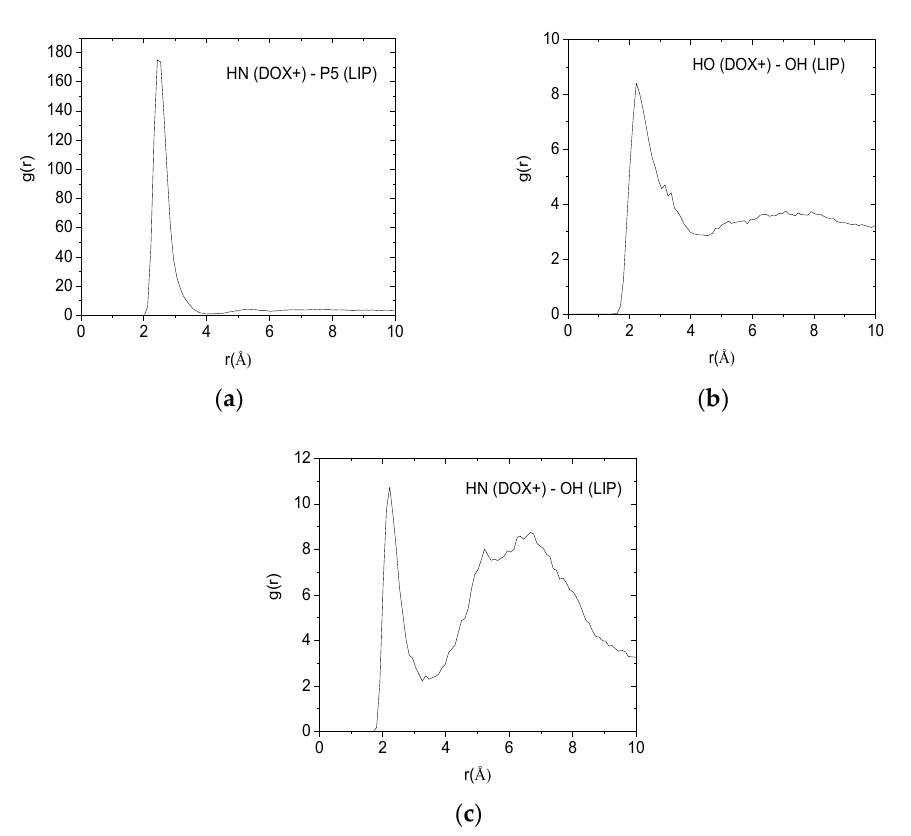
Figure 9. Pair correlation functions among atoms belonging to the protonated drug molecules (DOX+) and the DPPG lipids (LIP). ( a ) Pairs between amine hydrogens of DOX+ (HN) and hydroxyl oxygens of the lipid (OH). ( b ) Pairs between hydroxyl hydrogens (HO) of DOX+ and hydroxyl oxygens (OH) of the lipid. ( c ) Pairs between amine hydrogens of DOX+ (HN) and phosphorus (P5) of the lipid.